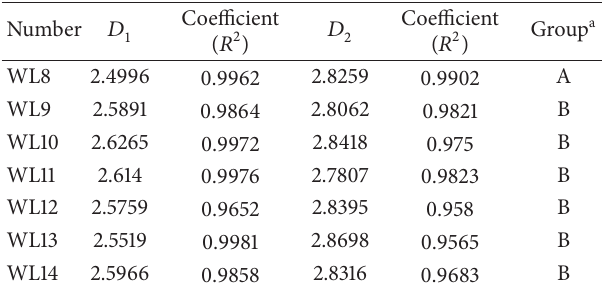
Table 4: Fractal dimensions derived from fractal FHH model.